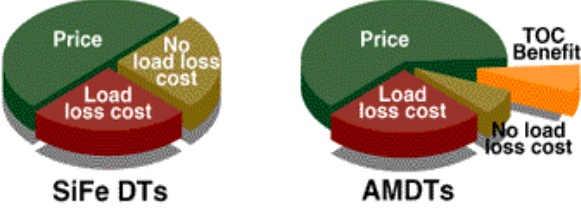
Figure 5. “Advantages of amorphous transformers”. Source: Targosz & Topalis (2008)